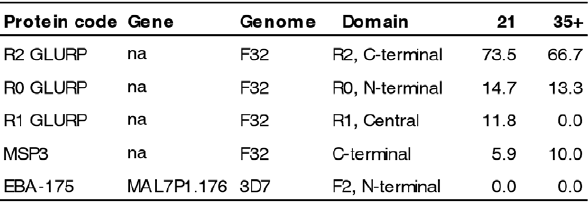
Figure 1. Proportion of malaria naı¨ve volunteers acquiring IgG against GLURP, MSP3 and EBA175 antigens after controlled experimental P.falciparum infections. The percentage of malaria infected volunteers with a measurable IgG response against GLURP R0, R1, R2, MSP3 and EBA175 malaria antigens on day 21 (N=34) and/or day 35, 42 or 90 (N=30) post infection in descending order. In total 44 volunteers were included (Table S1) and the IgG response was measured by bead-based Luminex